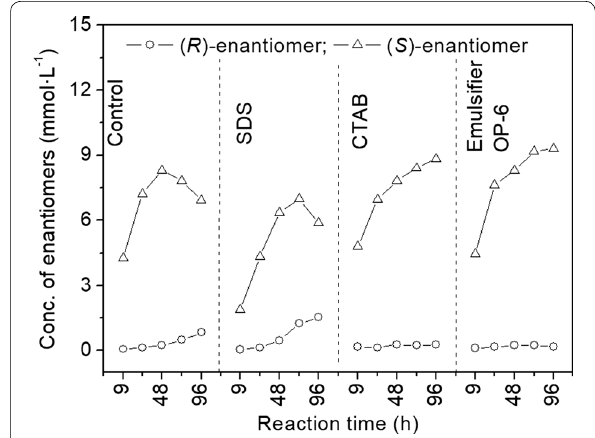
Fig. 1 Time course of two enantiomers of 2-octanol in the reaction systems containing surfactants